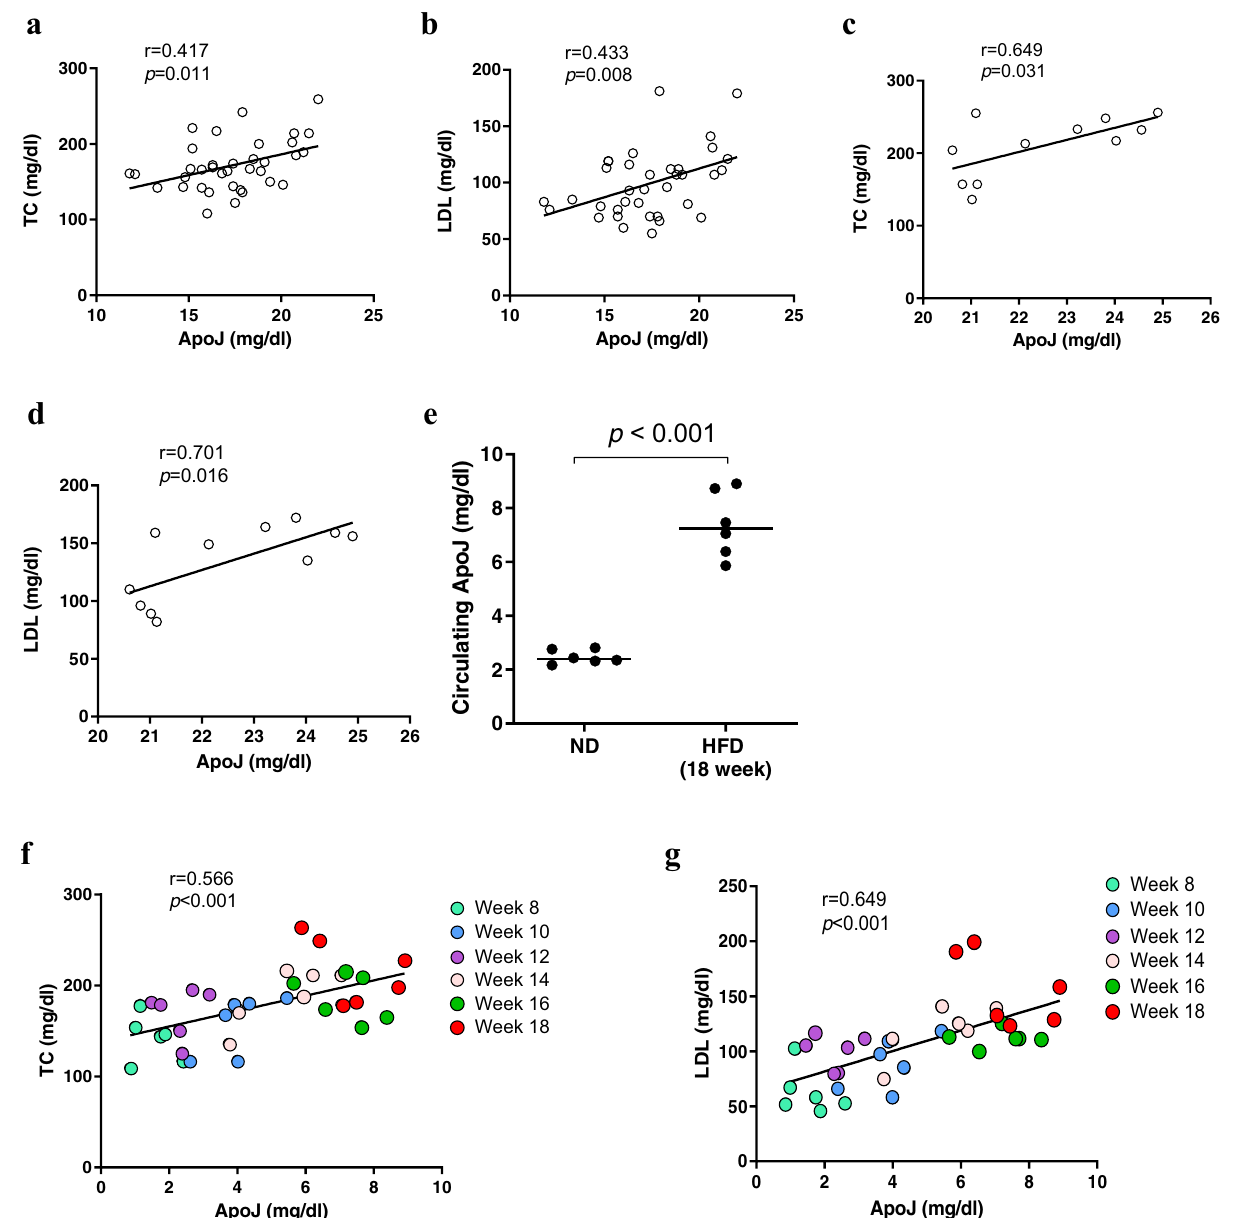
Fig. 6 The circulating ApoJ levels exhibited positive correlations with LDL and Chol. The correlations of ApoJ vs. a TC and b LDL in CHC patients; and c TC and d LDL in NAFLD patients with steatosis grade ≧ 2 are shown. e The serum ApoJ levels of mice with an ND or HFD for 18 weeks were determined by ELISA quanti fi cation and are presented as the mean ± range ( n = 6). The correlations of serum ApoJ vs. TC ( f ) and LDL ( g ) in mice with HFD-induced steatosis from 8 to 18 weeks feeding time